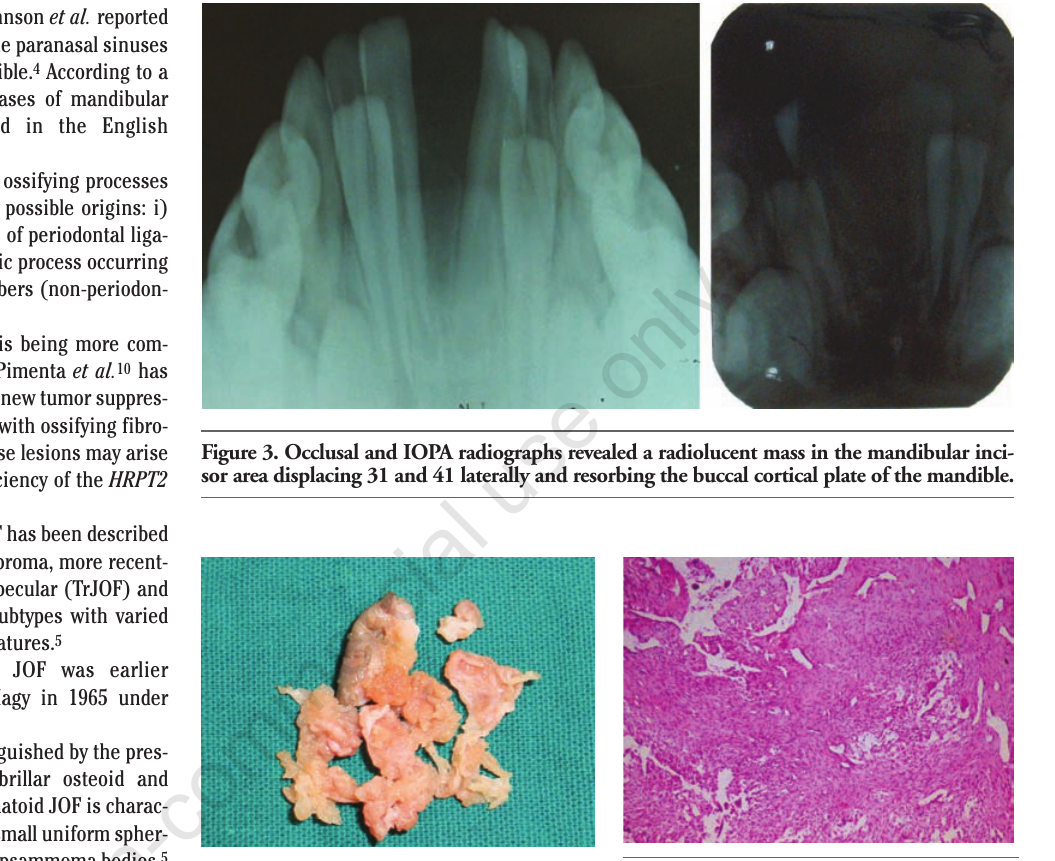
Figure 4. The macroscopic appearance of the lesion treated by surgical curettage.